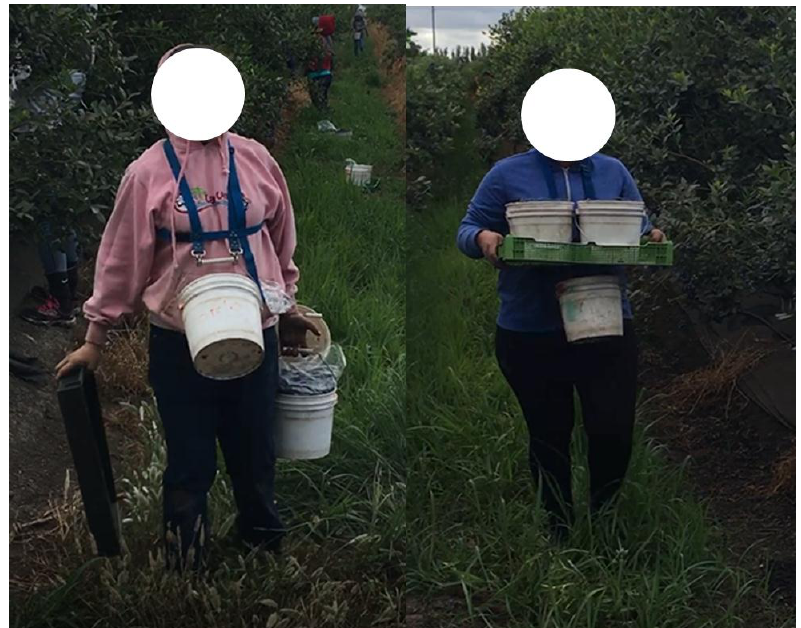
Figure 3. Examples of carrying posture.